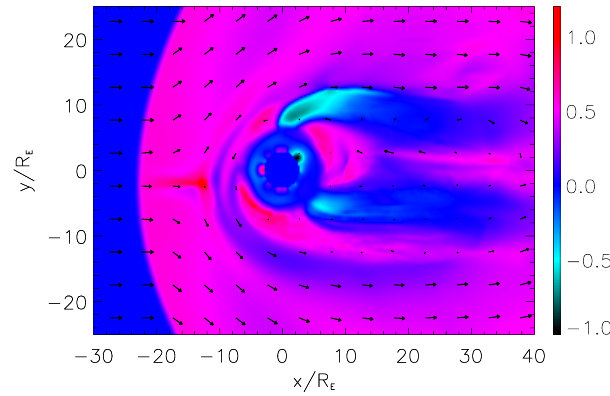
Fig. 12. Density variations corresponding to Fig. 7, here with a tilt of π/ 6 for the magnetic dipole axis.